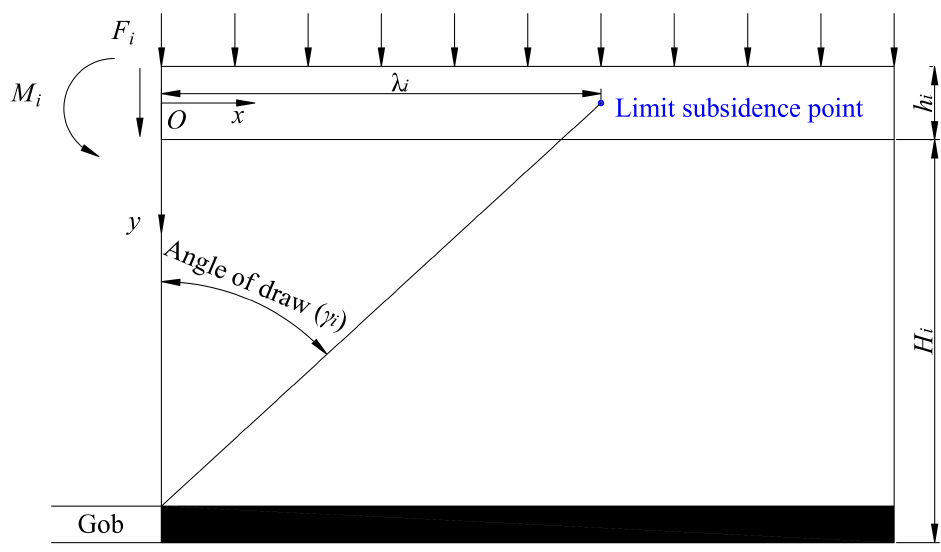
Figure 2. Mechanical model of elastic foundation beam of the overburden